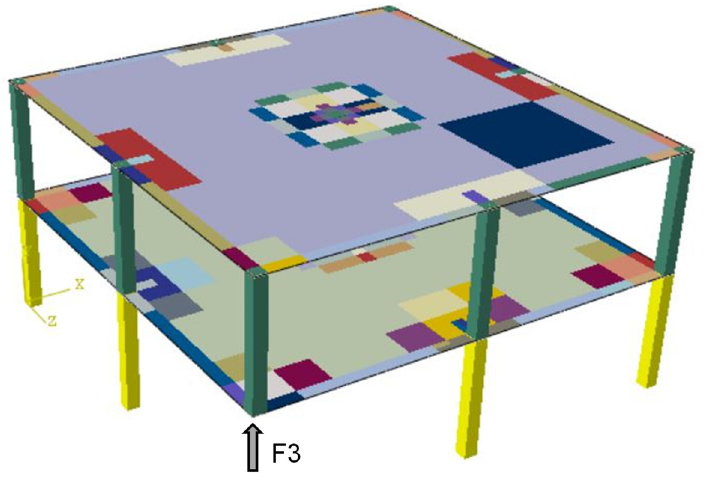
Figure 2. Finite Element (FE) model without the ground floor column P3 (column removed). Colours represent sections with different amounts of reinforcement according to the building details